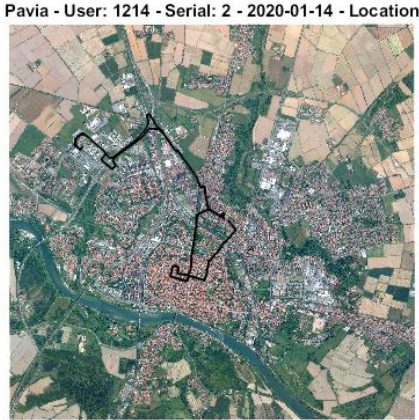
Figure 14. Example of the tracks acquired by a user